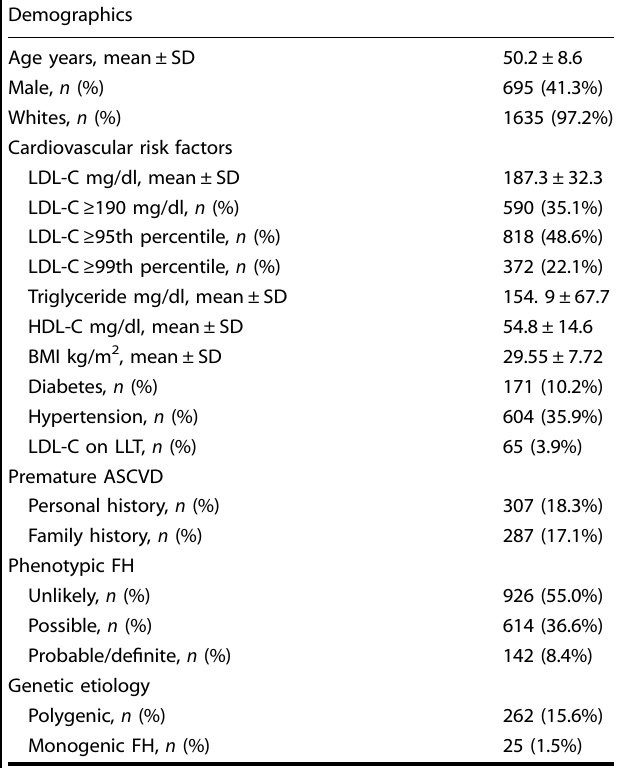
Table 1. Participant characteristics ( n = 1682).